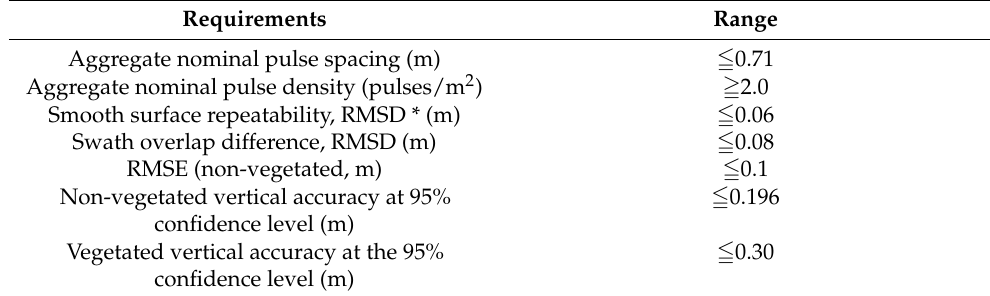
Table A1. Minimum requirements (quality level 2, QL2) of 3D Elevation Program (3DEP) LiDAR products.